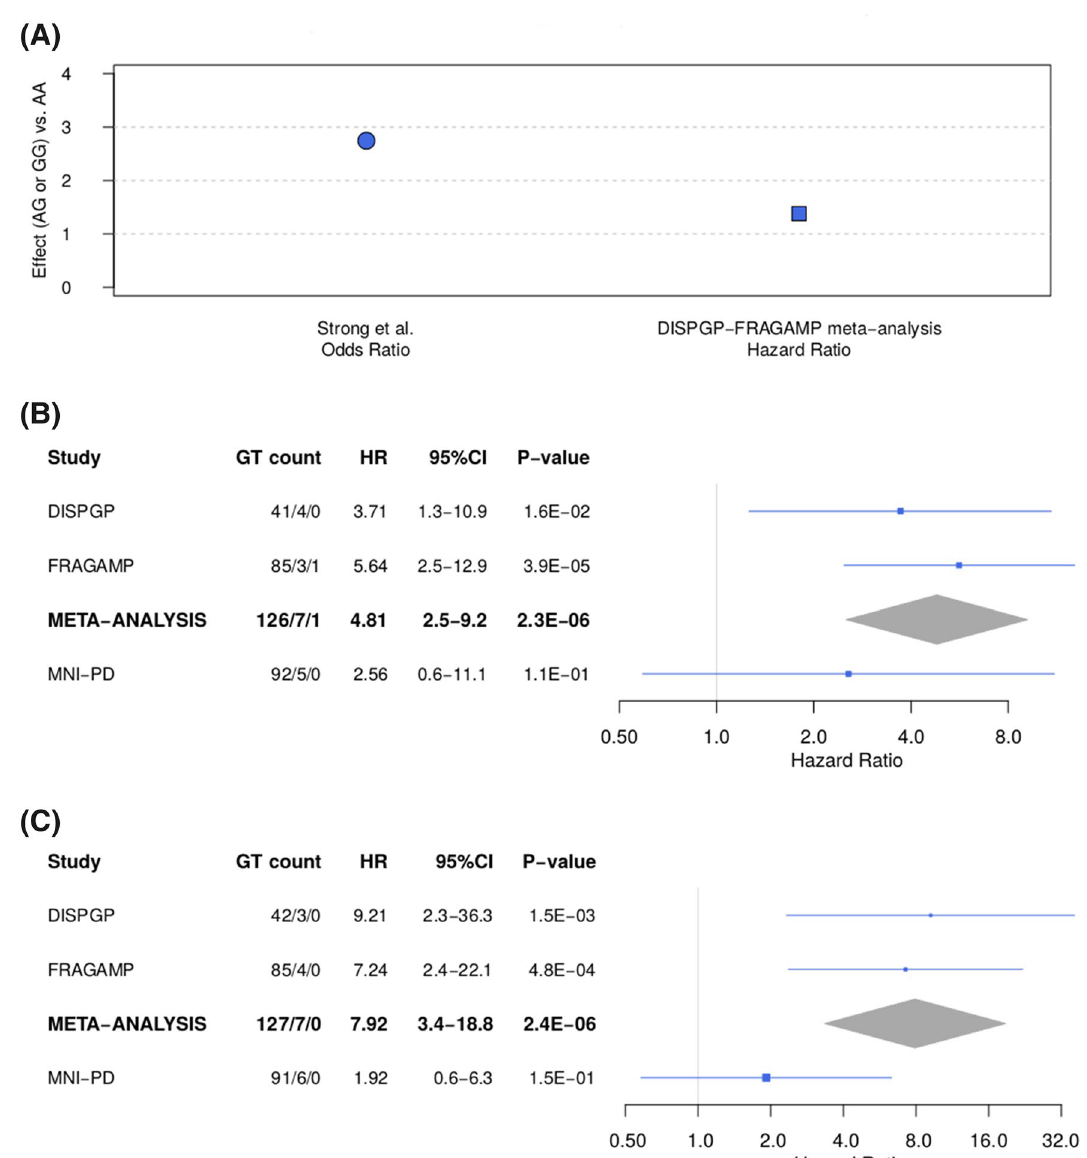
Figure 2. (A) Odds and hazard ratios of the replicated OPRM1 variant for the effect allele G (genotypes AG or GG) versus the other allele A with genotype AA. (B) Forest plot of the Hazard ratio of rs2233019 in gene MAD2L2 in the two discovery studies DISPGP and FRAGAMP, the meta-analysis, and the replication study MNI-PD. (C) Forest plot of the Hazard ratio of rs35350783 in gene MAP7 in the two discovery studies DISPGP and FRAGAMP, the meta-analysis, and the replication study MNI-PD. For (B,C) , the point/center of the triangle corresponds to the Hazard ratio, the line/dimension of the triangle corresponds to the 95% confidence interval. GT genotype, HR hazard ratio, CI confidence